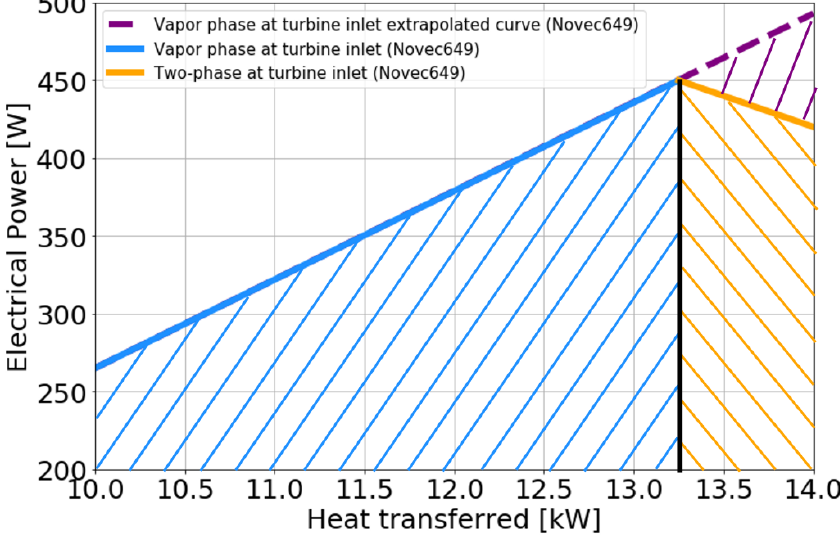
Figure 20. Comparison of the electrical production between two sizes of heat exchangers.